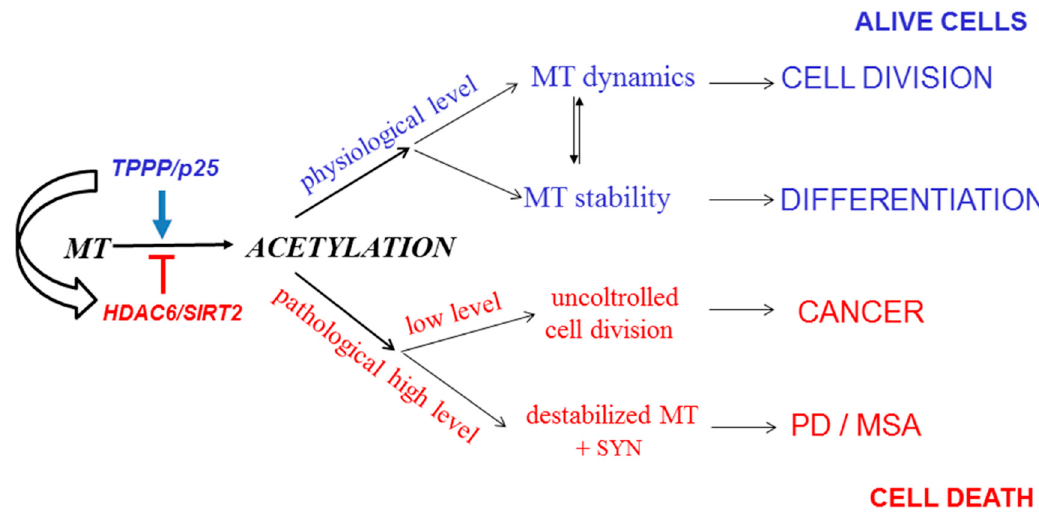
Figure 8. From regulation of microtubule acetylation to potential connection of Parkinson’s disease (PD) and cancer. MT: microtubule. MSA: multiple system atrophy.